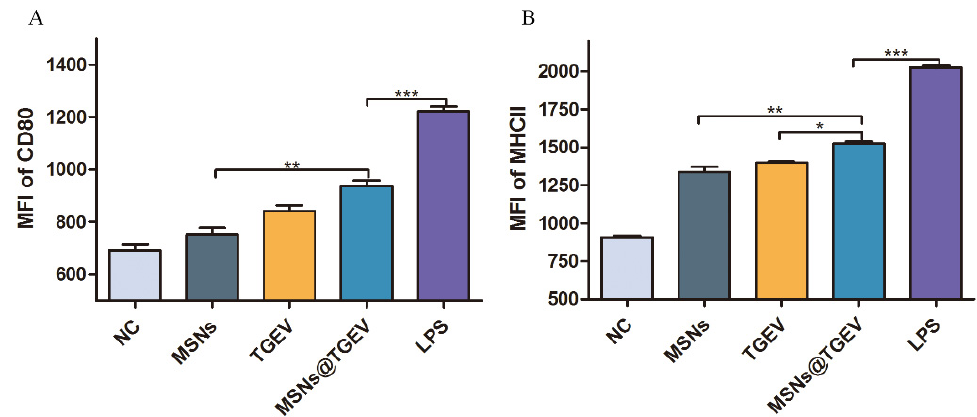
Figure 4. Inactivated TGEV vaccine with MSNs promotes DC maturation in vitro. The im-DCs were treated with MSNs, inactivated TGEV, and inactivated TGEV vaccine with MSNs for 24 h, respectively. The maturation of DCs was investigated by the expression of MHCII and CD80. Untreated im-DCs were negative control, and im-DCs treated with LPS were positive control. MFI were plotted using GraphPad Prism. ( A ) the expressions of CD80; ( B ) the expressions of MHCII. Data were presented as mean ± SD of three duplicate samples. Differences were considered significant at (*) p < 0.05, (**) p < 0.01, (***) p < 0.001.